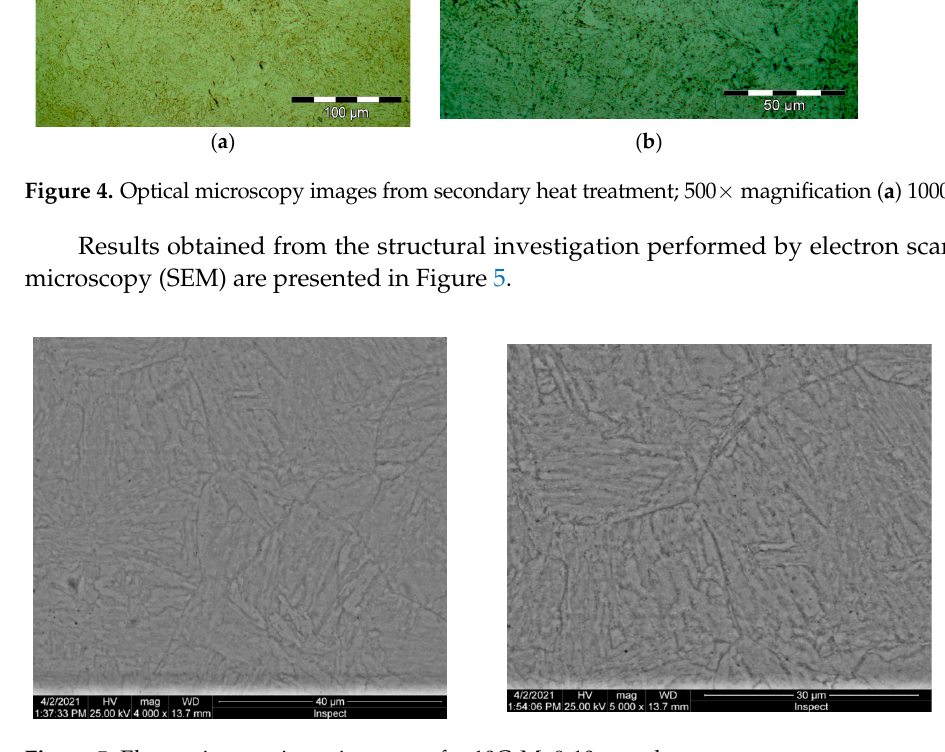
Figure 5. Electronic scanning microscopy for 10CrMo9-10 sample. Results obtained for structural investigation of energy dispersion spectrometry